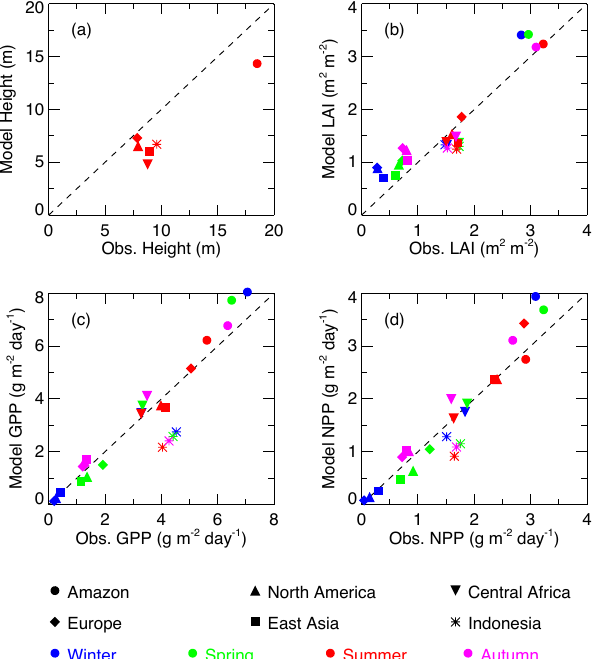
Figure 6. Comparison of annual (a) tree height and seasonal (b) LAI, (c) GPP, and (d) (NPP between simulations and observa- tions for the six regions shown in Fig. 5a. GPP data set is from Jung et al. (2009). Values at different regions are marked using different symbols, with distinct colors indicating seasonal means for winter (blue, December–February), spring (green, March–May), summer (red, June–August), and autumn (magenta, September–November).